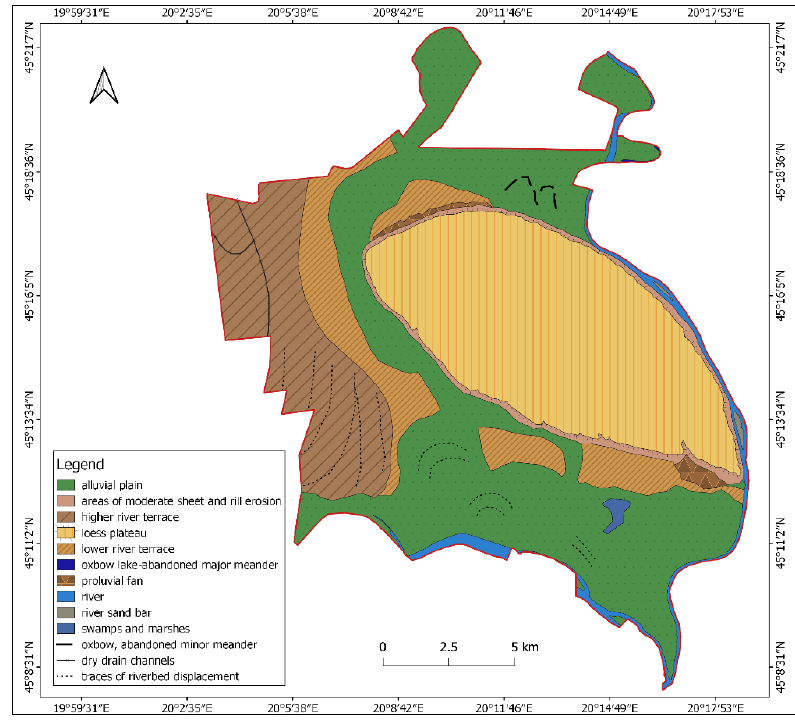
Figure 4. Main geomorphological units/relief units of the study area.